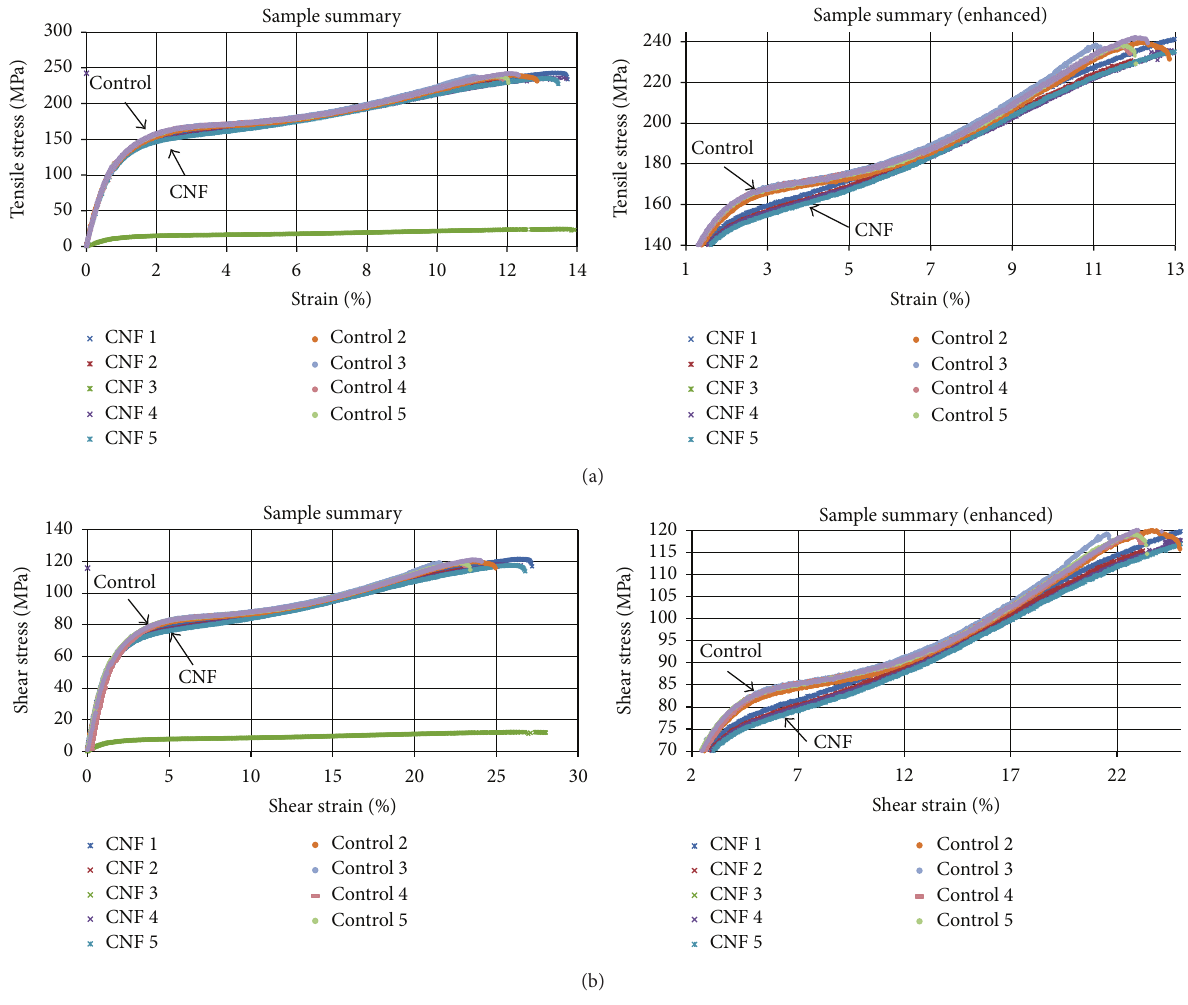
Figure 4: Tensile stress-tensile strain (a) and shear stress-shear strain (b) graphs for all tested samples. The enhanced graph shows the difference between the control and CNF modified samples just after yielding. The single data curve outlier in both graphs is from the CNF 3 sample. This sample experienced a testing flaw and was not included in the calculations for Table